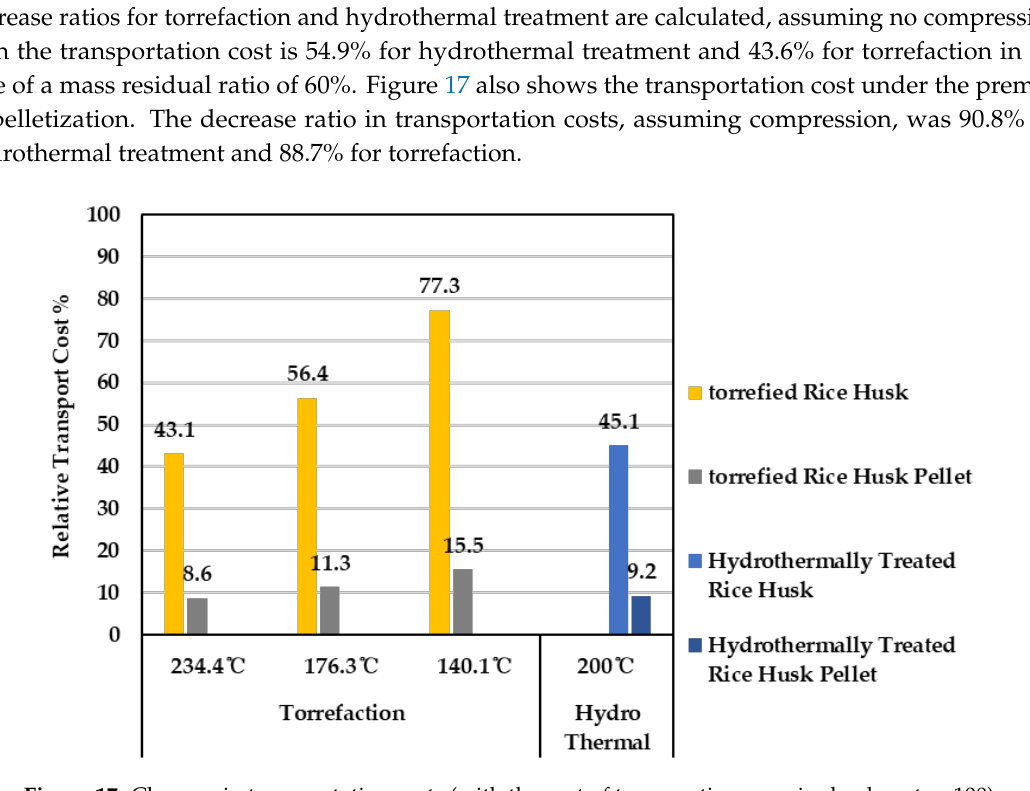
Figure 17. Changes in transportation costs (with the cost of transporting raw rice husks set as